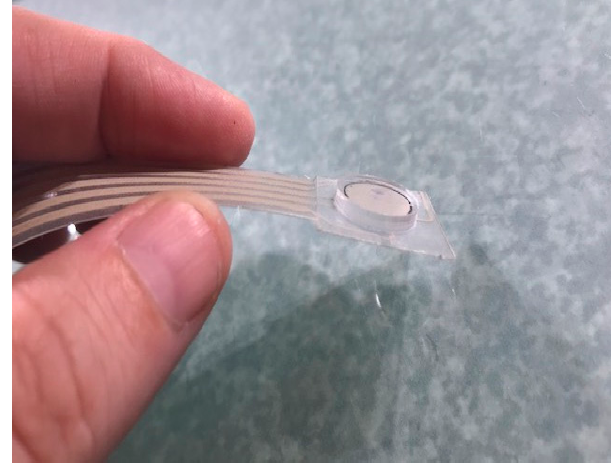
Figure 25. A prototype shear sensor.